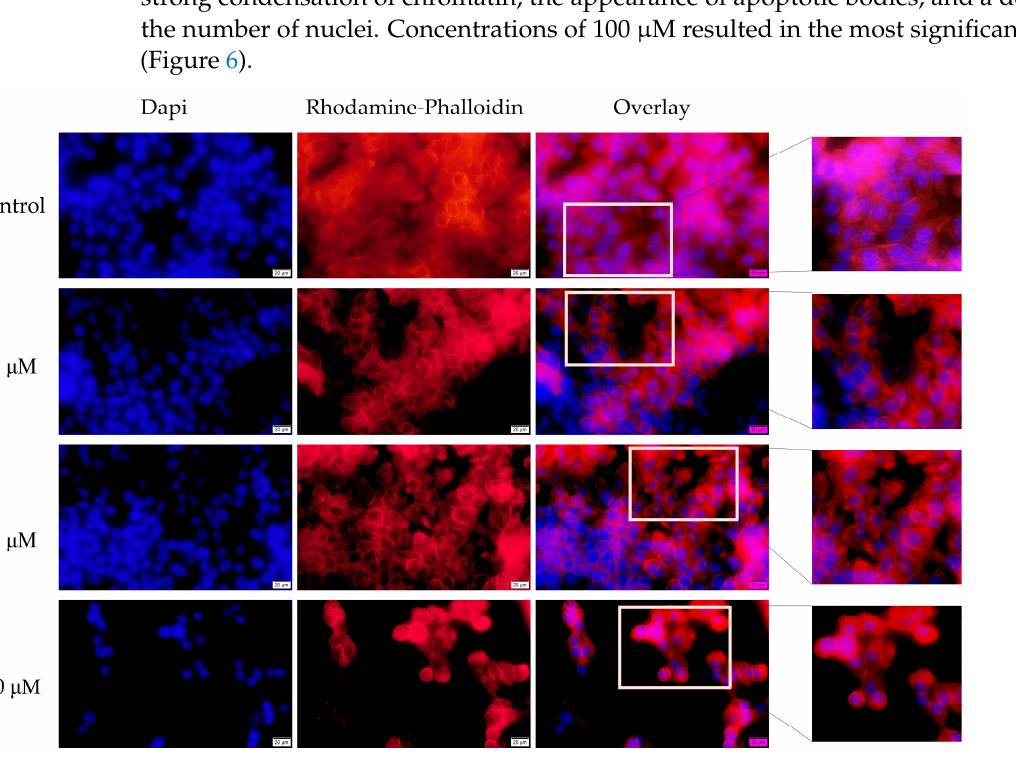
Figure 5. Quantitative evaluation of cell migration expressed as a percentage compared to control (non-stimulated) cells. The results are expressed as mean values ± SD of three independent experi- ments performed in triplicate. The statistical differences between control and cells stimulated with tetracycline and ampicillin were determined by applying the one-way ANOVA analysis followed by the Dunnett’s multiple comparisons post-test (** p < 0.01; *** p < 0.001 and **** p < 0.0001).